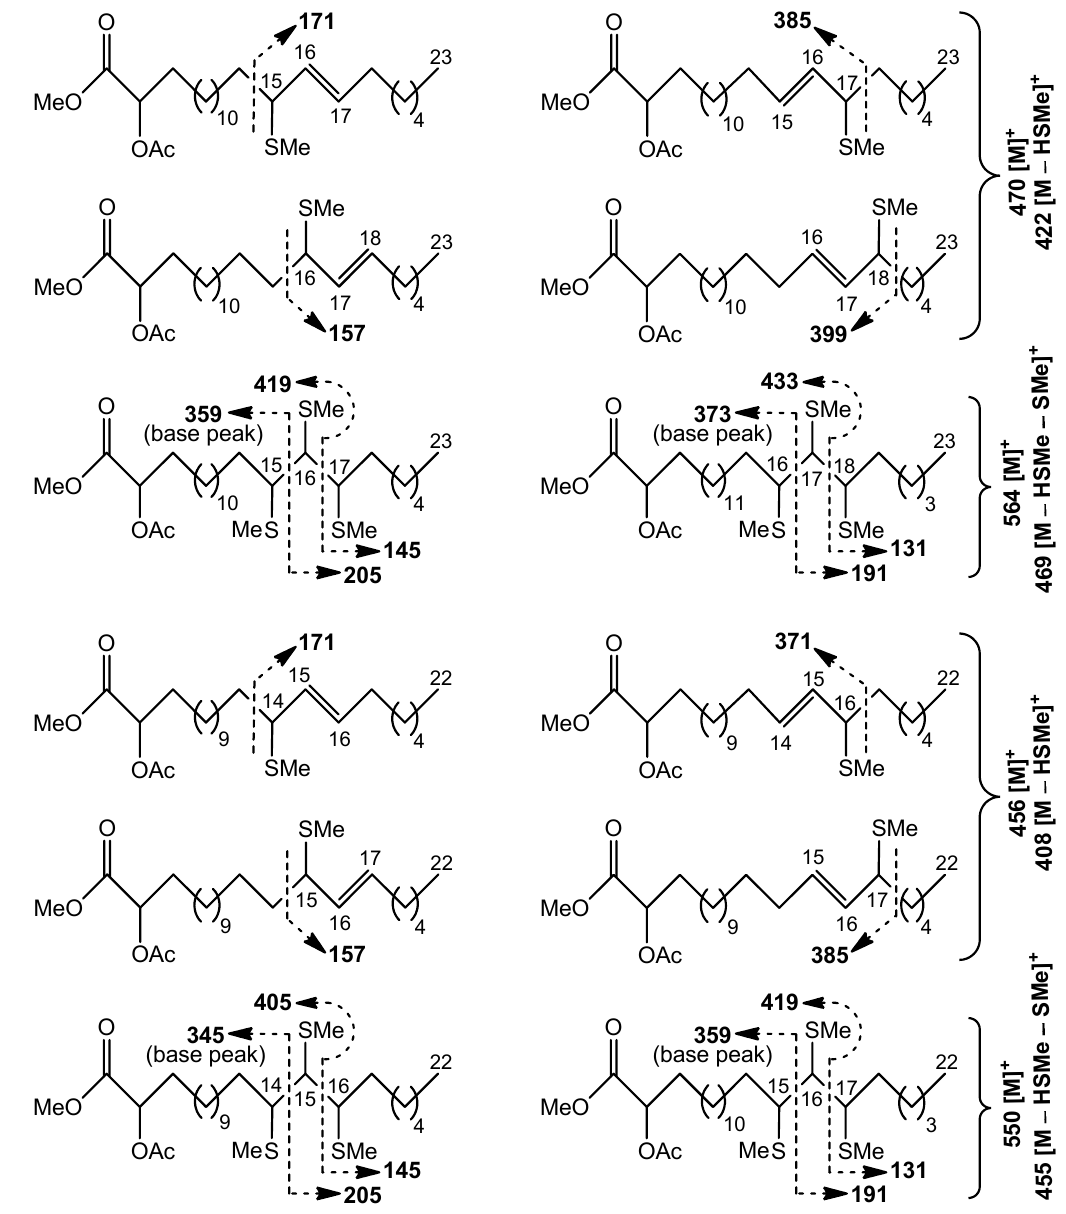
Scheme 4. GC-MS cleavage patterns for the methyl esters of 2-acetyloxy C 23 and C 22 acids, containing an allylic methylthio group or three methylthio groups.